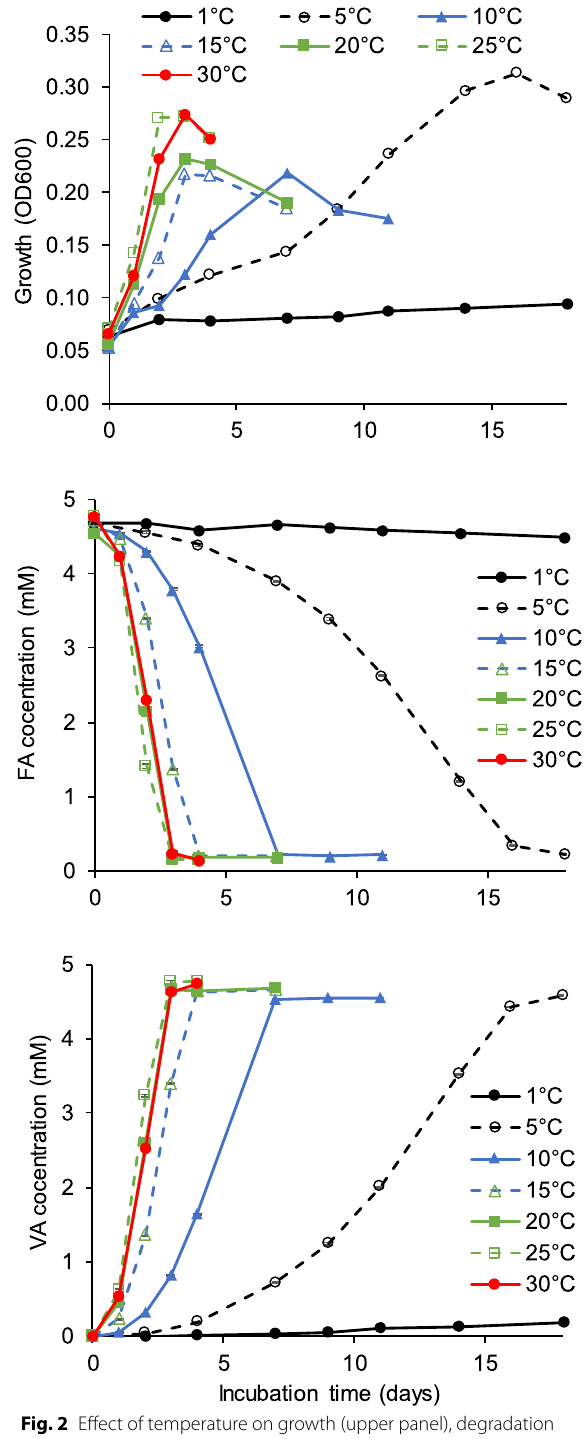
Fig. 2 Effect of temperature on growth (upper panel), degradation of 5 mM FA (middle panel), and VA production (lower pannel) by P. aromaticivorans AR20-38. Data represent mean values of three replicates (SDs <